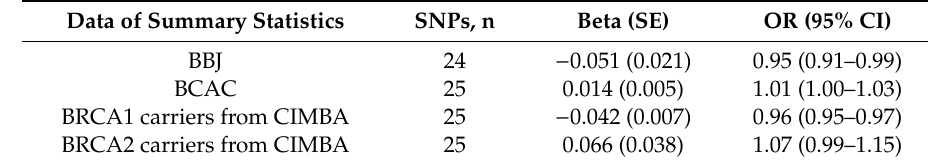
Table 1. Results of penalized robust inverse variance weighted (PRIVW) method for causal inference of Rheumatoid arthritis as risk factors for breast cancer risk in two-sample Mendelian randomization. Data of Summary Statistics